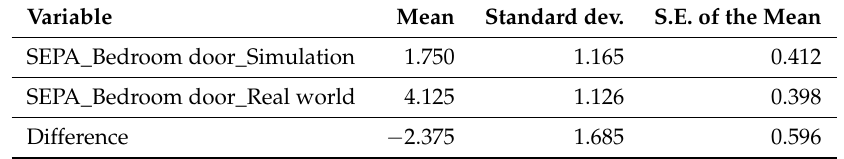
Table 2. Comparison test between real and simulated SEPA in Bedroom door (ADL: Go to bed).